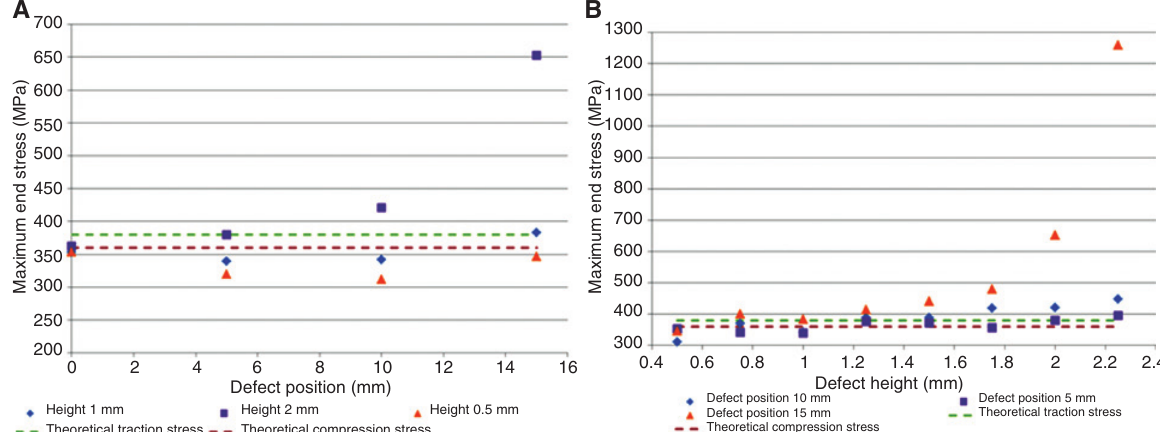
Figure 9 Influence of defect position and dimensions in maximum end stress.